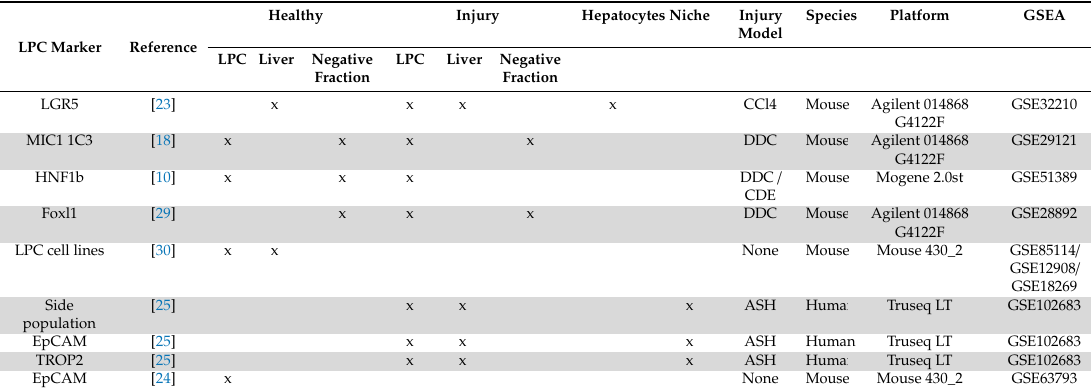
Table 1. Biliary epithelial cells (BEC) gene expression